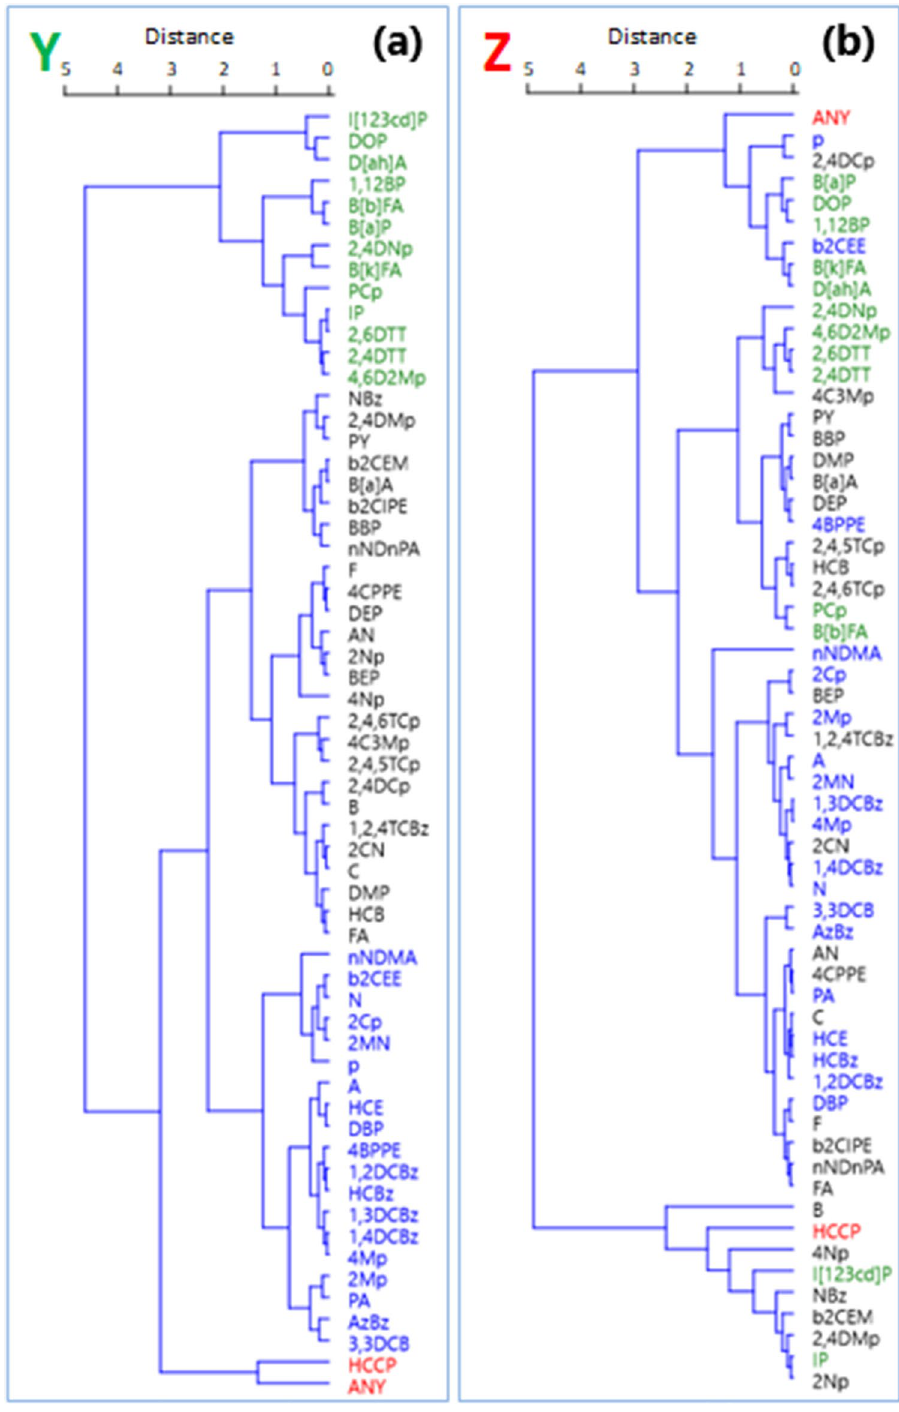
Figure 6. Comparing cluster analysis results of standardized recoveries of 60 SVOCs as measured ( a ) when internal standards were added on day 0 of samples preparation and aged for 36 days (condition Y ) and ( b ) when internal standards addition was delayed until after 36 days of incubation (condition Z ). Abbreviations represent compounds; the identities are supplied in Online Resources 1). Four groupings were identified in Y ; members of a grouping are color-coded identically to facilitate tracing in Z . (Algorithm: Ward’s method; cophenetic correlation: coefficients: